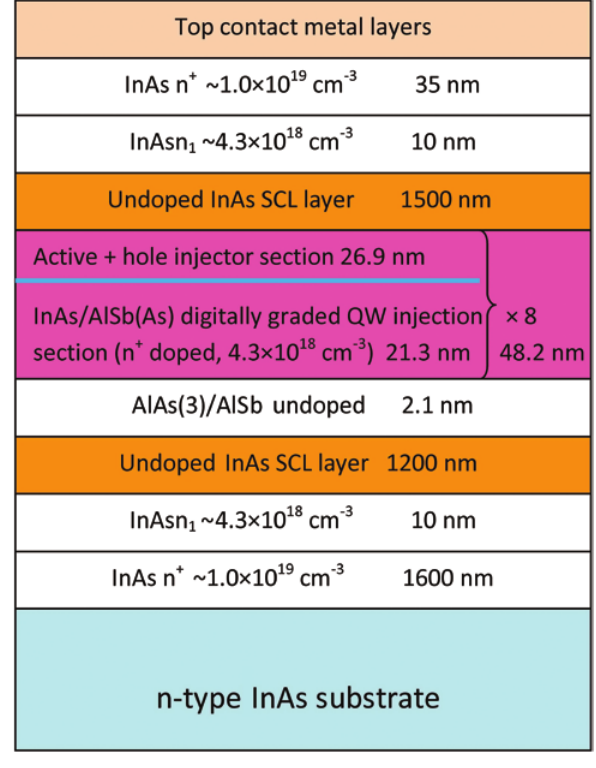
Figure 3: Schematic diagram of the layer structure of the ICL sample. The interband cascade region consist of eight nominally identical modules; each module contains a 26.9-nm-thick active and hole injection section and a 21.3-nm-thick electron injector section. Each active section consists of two InAs electron wells and Figure 2: Light-current density-voltage ( L - J - V ) characteristics of two GaInSb hole wells. In order to achieve rebalancing of electrons the terahertz QCL (V843). The J - V curve in (A) is measured at 10 K. and holes in the active section, some wells in the InAs-AlSb(As) = ~ 5.5 V, the J - V curve shows a shoulder, corresponding to At V 1 electron injector section are n + -doped at 4.3 × 10 18 cm -3 = ~ 9.4 V, the J - V curve shows the e - 1 tunneling resonance. At V 2 another shoulder, corresponding to the e -2 tunneling resonance.